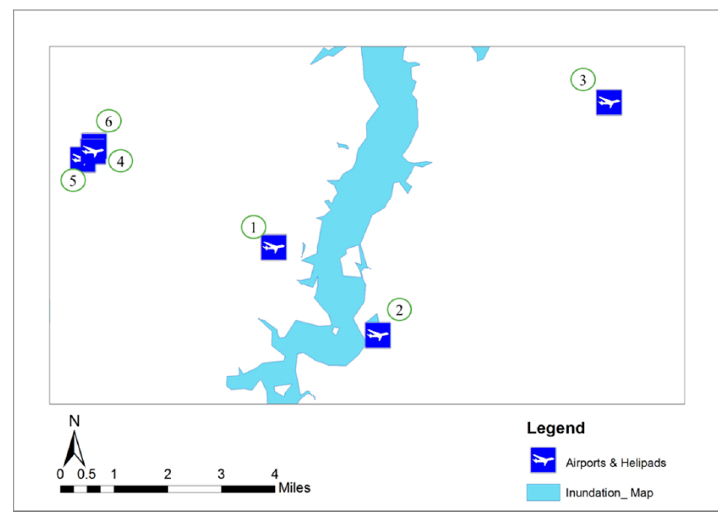
Figure 11. Location of airport under inundation due to the Flood of May 2015. Table 7. List of airports vulnerable to the flood of May 2017 in Kansas City, Missouri. Airport Location (Figure 12) and Names